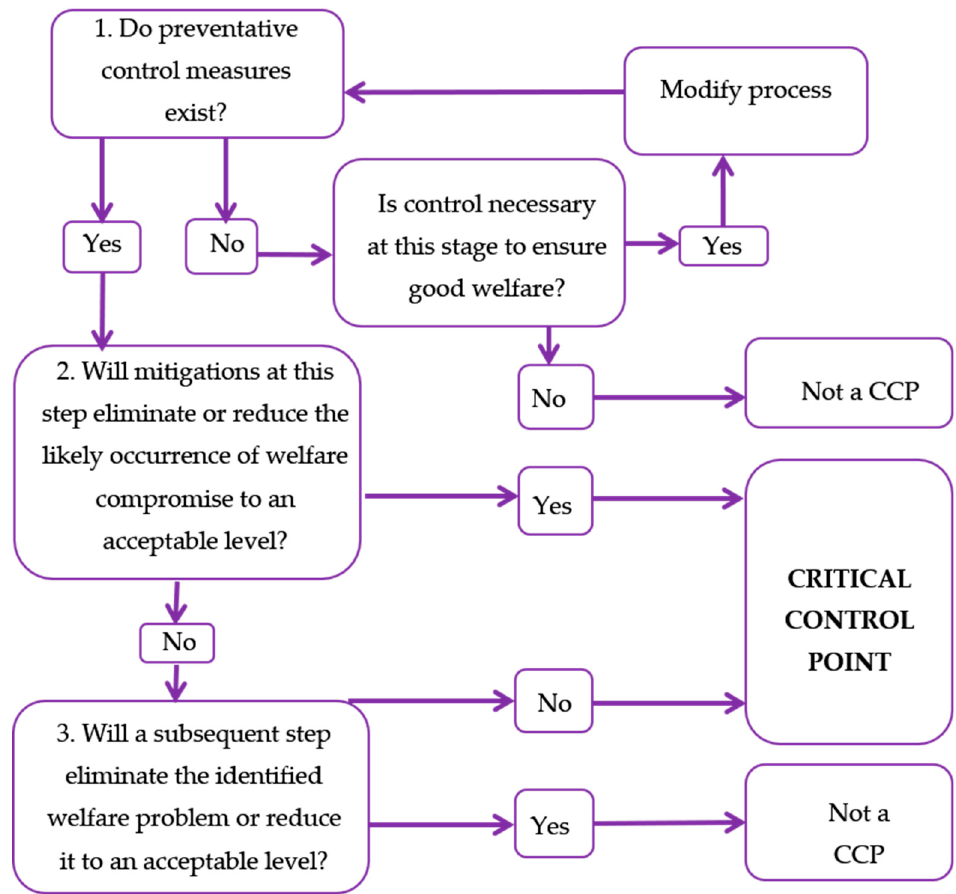
Figure 2. Critical control point algorithm (adapted from